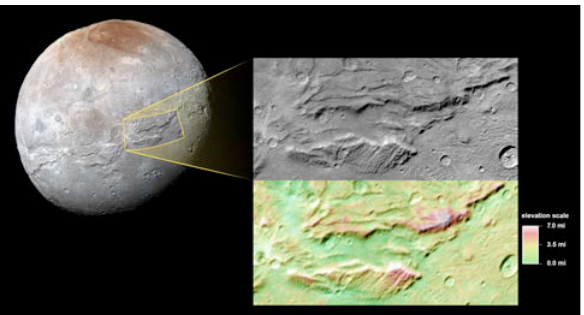
Figure 5. Portion of Charon topographic map showing part of the equatorial trough and fracture system along the northern margin of Vulcan Planum, which forms the palin to the bottom of the image. The trough has relief ranging from a few 100 m to 3-4